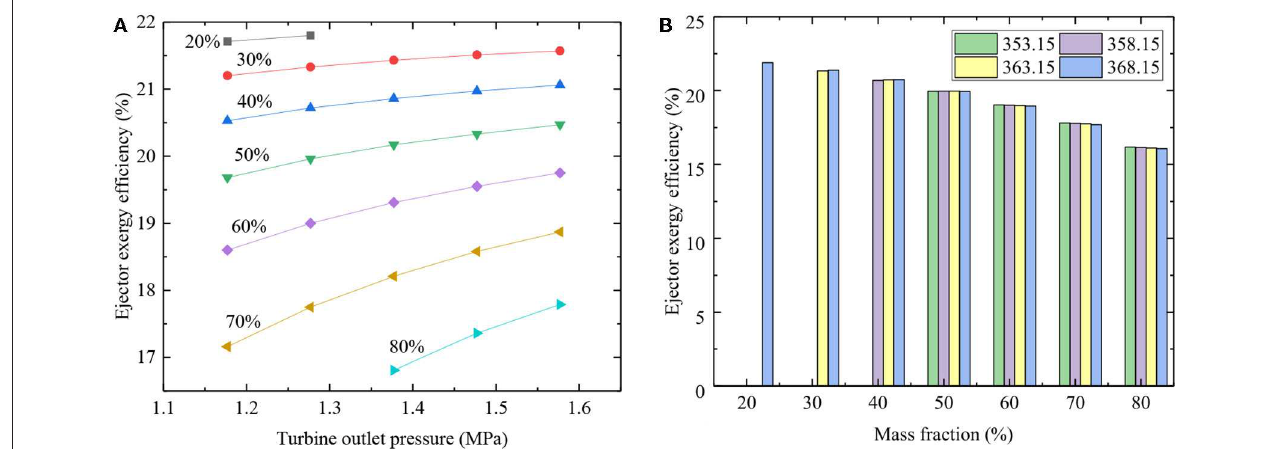
FIGURE 10 | Effect on the ejector exergy efficiency. (A) Turbine outlet pressure and mass fraction; (B) mass fraction and evaporation temperature.